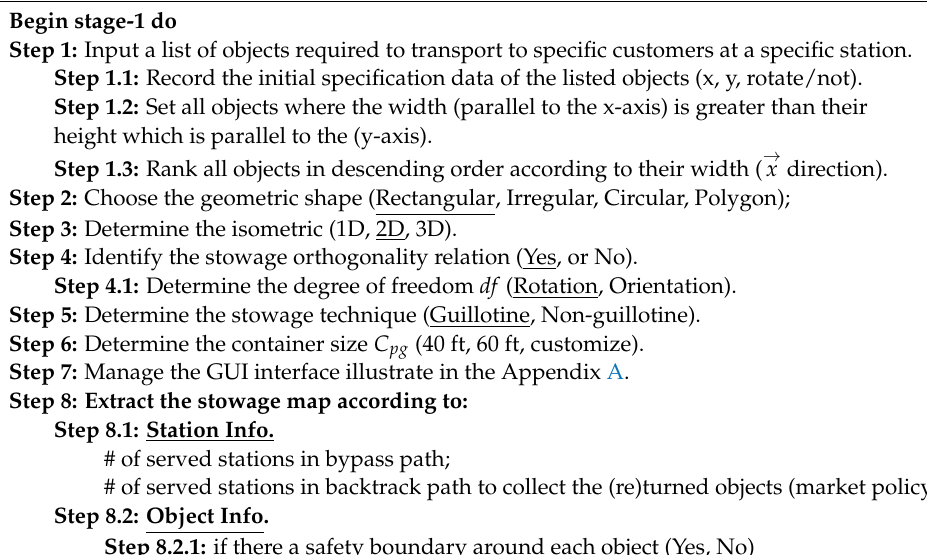
Algorithm 1 Stage-1: Stowage Steps